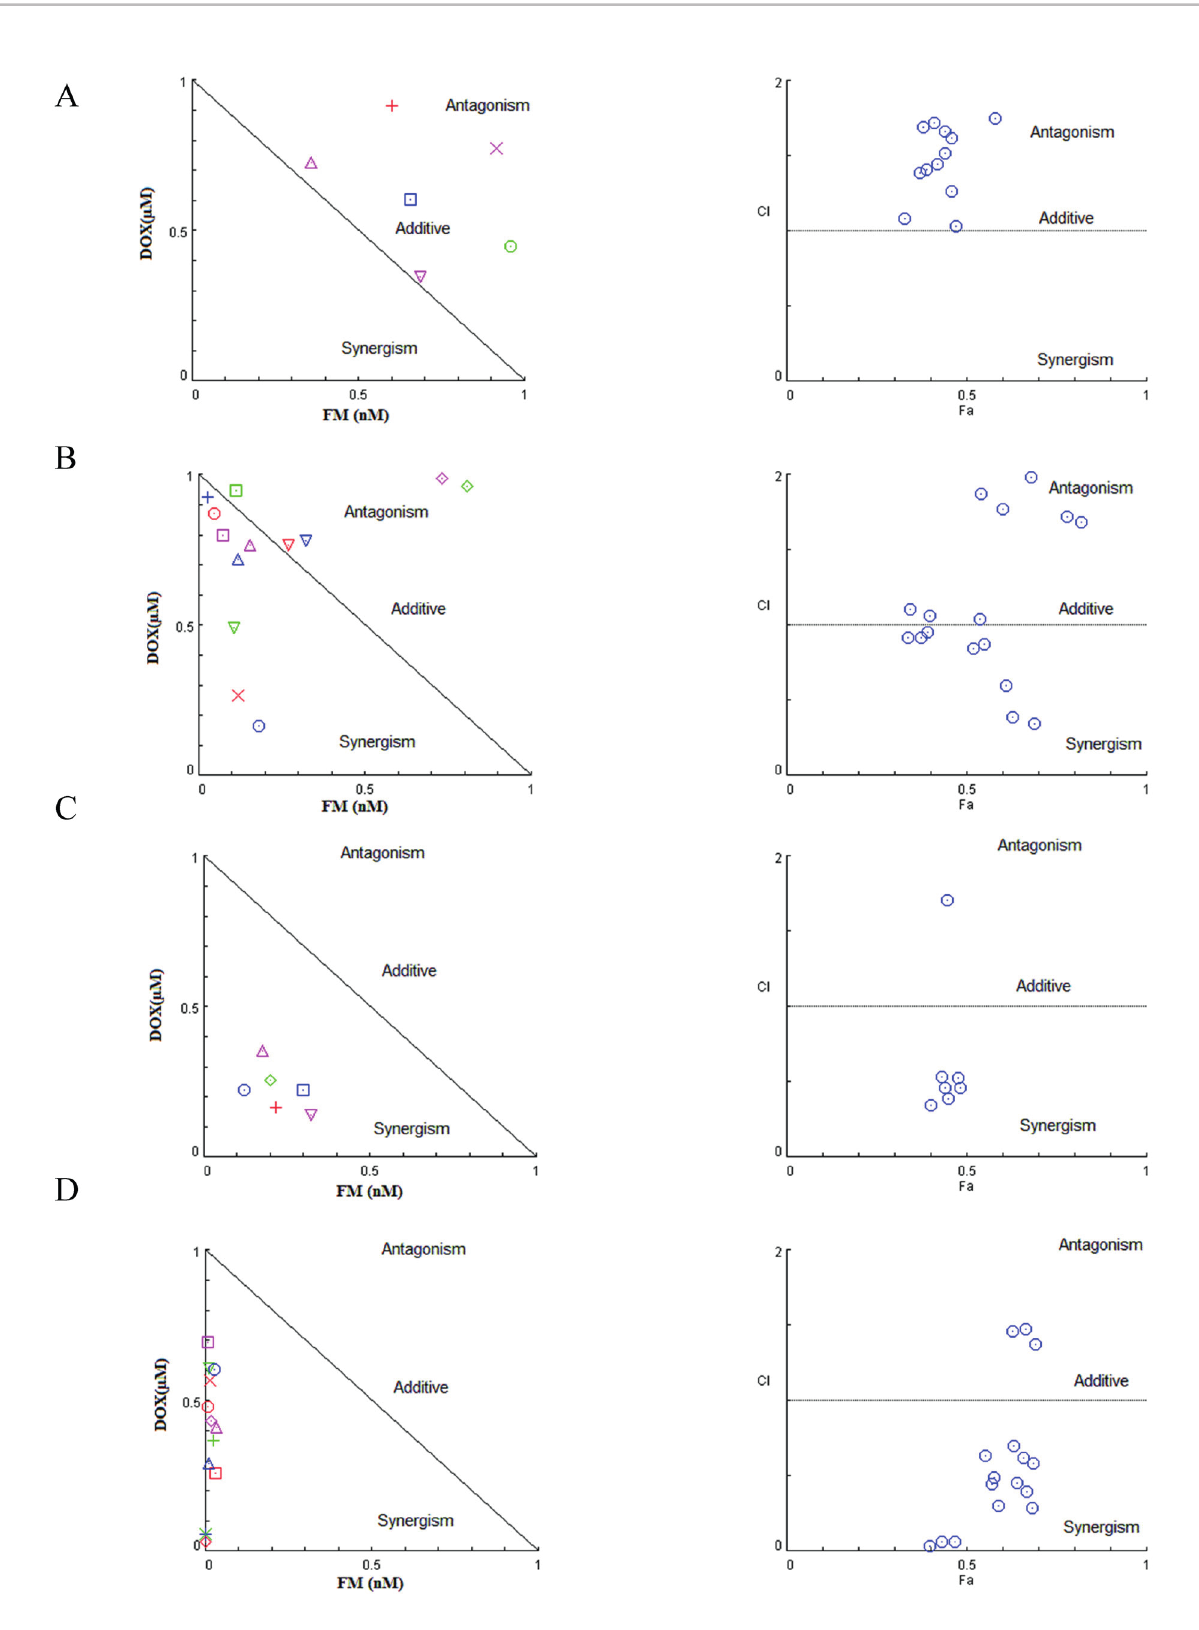
FIGURE 2 - Synergistic effect of doxorubicin (DOX) and FM19G11 (FM). (A) MCF-7 in normoxia; (B) MCF-7 in hypoxia; (C) CSC-LCs in normoxia; (D) CSC-LCs in